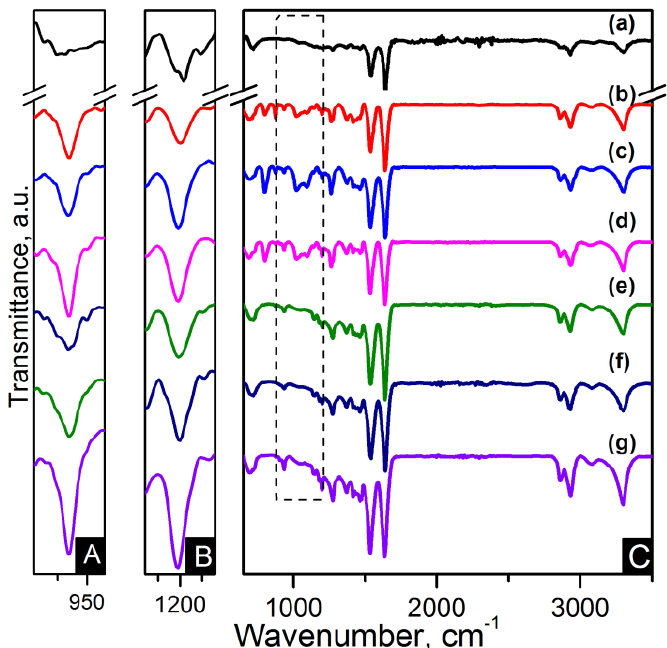
Figure 5. FTIR spectra of ( A ) zoom-in of ~935 cm − 1 peak ; ( B ) zoom-in of ~1200 cm − 1 peak and ( C ) region of 900–3500 cm − 1 of the samples: ( a ) pure PA66; ( b )